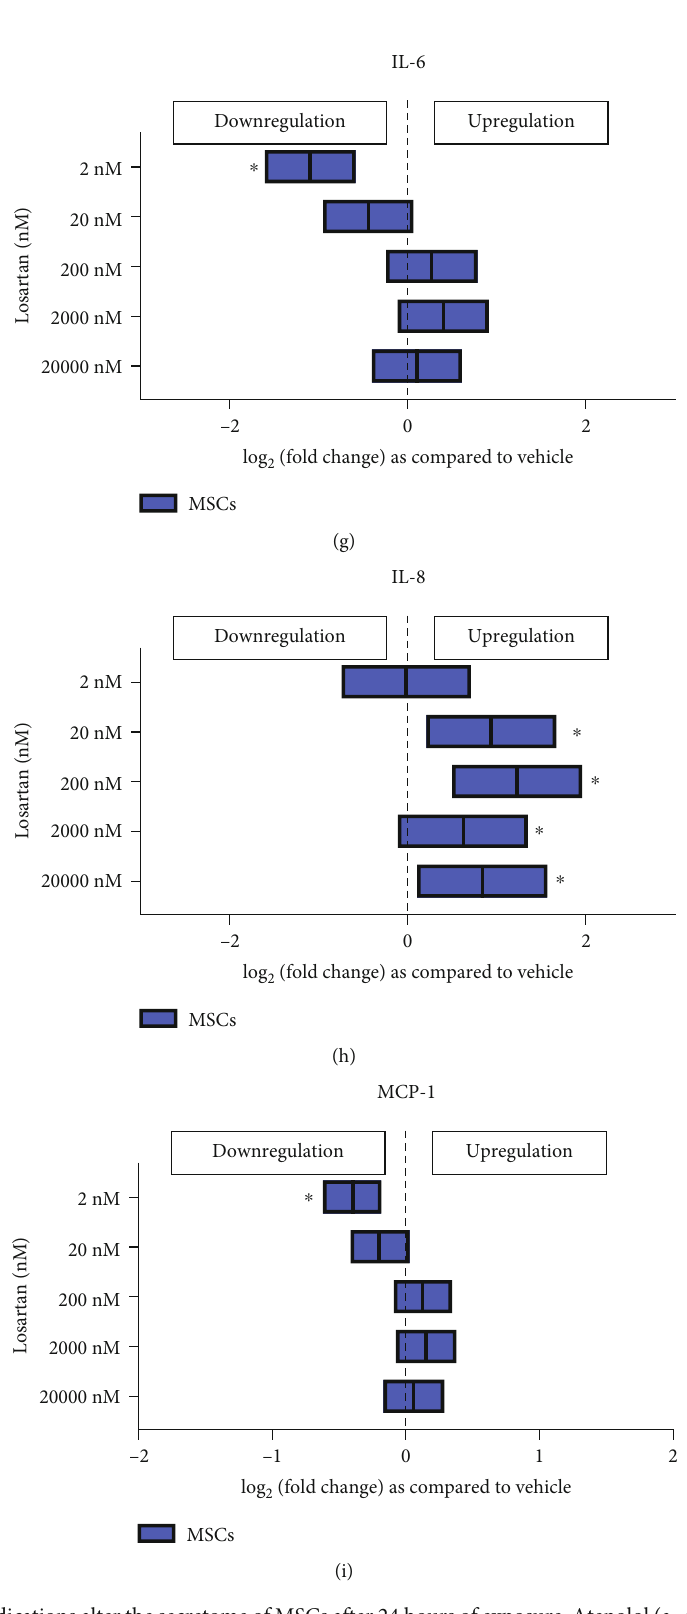
Figure 2: Antihypertensive medications alter the secretome of MSCs after 24 hours of exposure. Atenolol (a – c) reduced IL-6, MCP-1, and IL- 8 secretions; captopril (d – f) increased IL-6, IL-8, and MCP-1 secretions; and losartan (g – i) increased IL-8 but reduced IL-6 and MCP-1 secretions. Signi fi cance is shown by ∗ p < 0 : 05 . All fold changes are as compared to vehicle